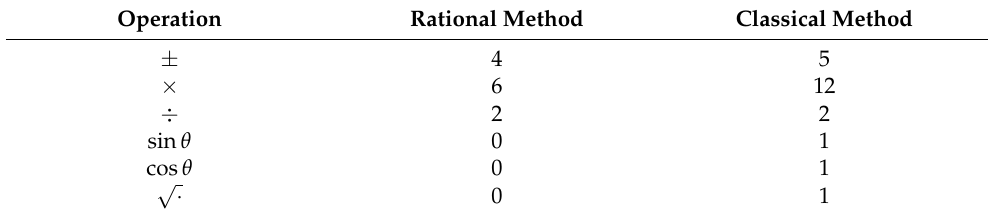
Table 3. Number of operations for each rotation computation.